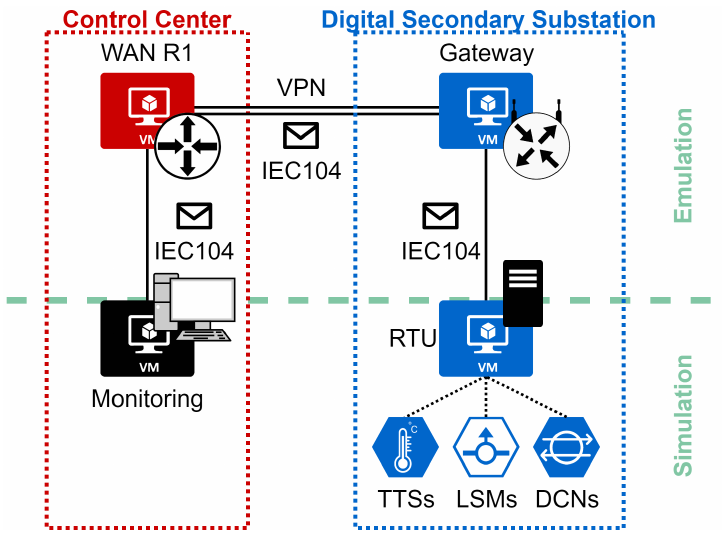
Figure 5. The simulation